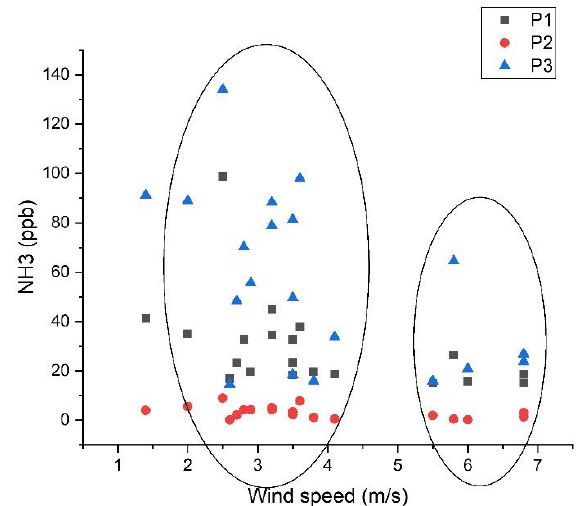
Figure 9. Ammonia concentrations are distributed in P1, P2, and P3 locations as a function of wind speed for the spring and summer seasons.